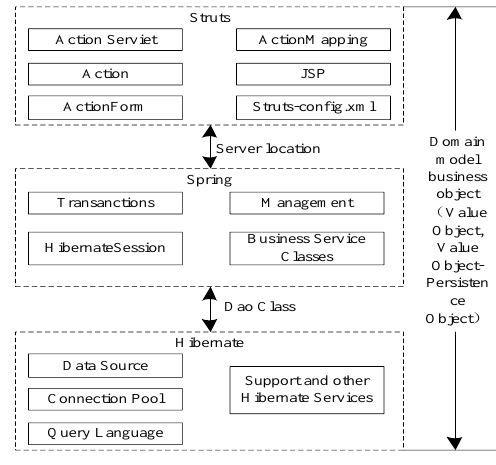
Figure 1. SSH frame